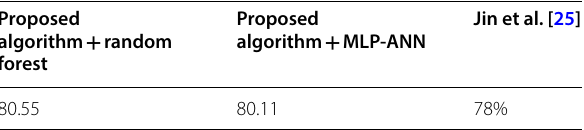
average classification accuracy Proposed algorithm random +